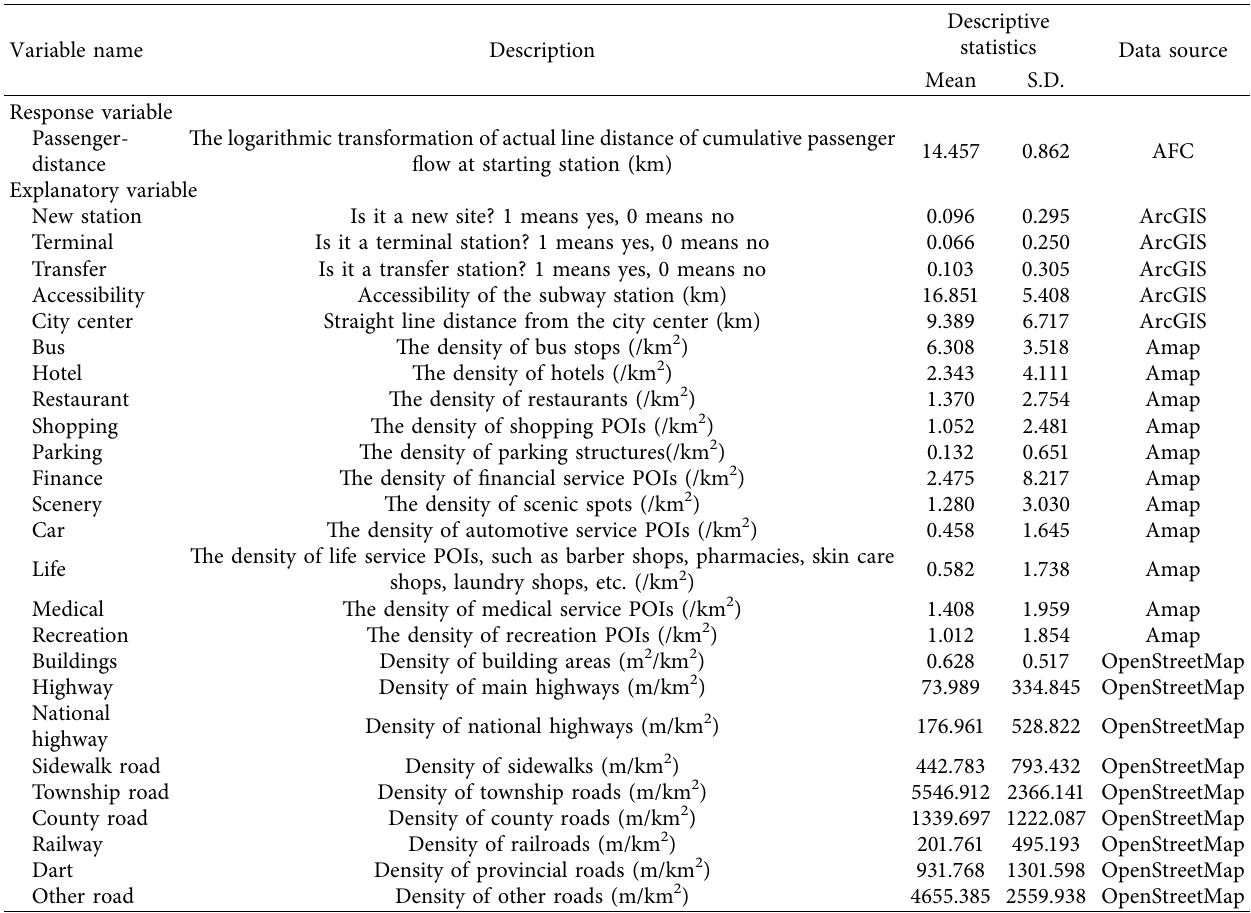
Table 2: Descriptive statistics of the